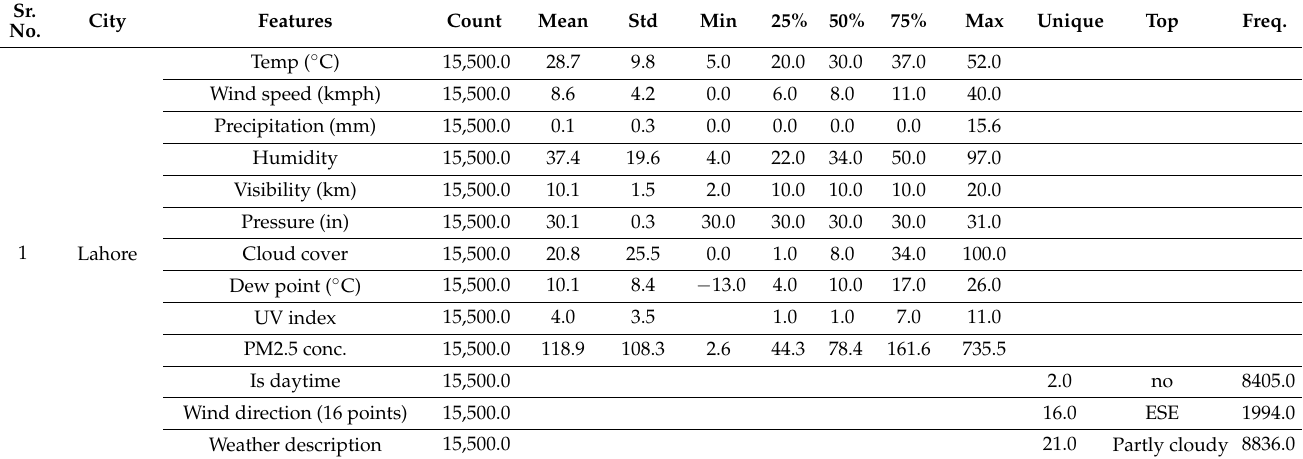
Table 1. Statistical distribution of the